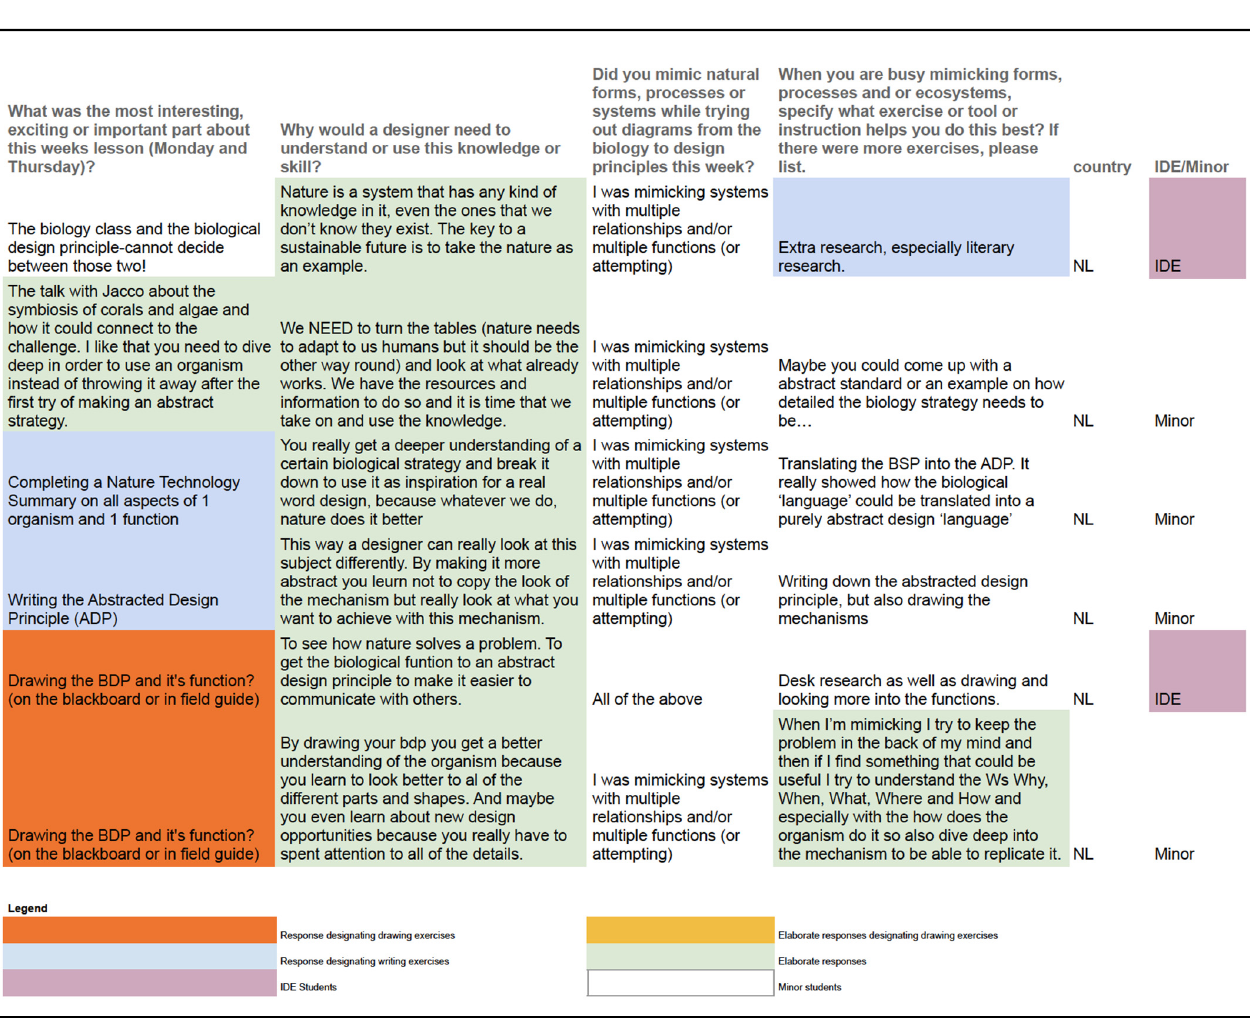
Figure 11. Interview responses of the student cohort mimicking systems in their